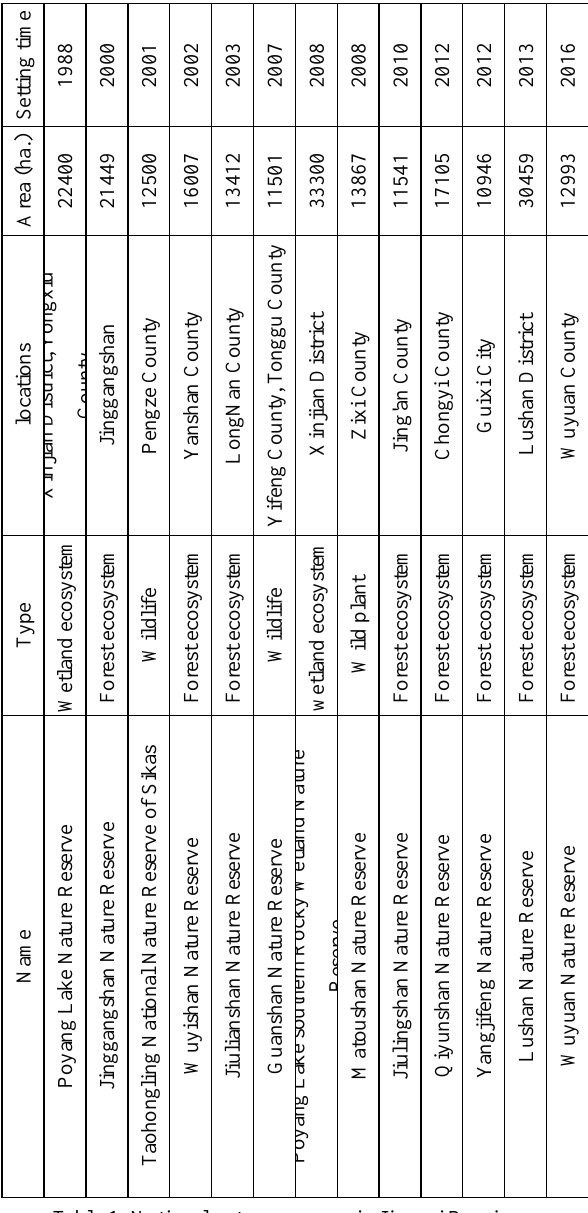
Table 1. National nature reserves in Jiangxi